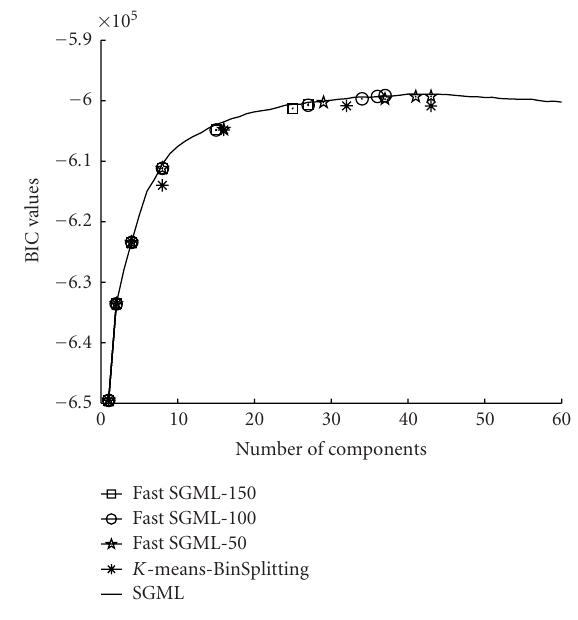
Figure 5: The learning curves of applying SGML, fast SGML, and K -means-BinSplitting in the 60-second speech data of one partic- ular male speaker in the NIST 2001 cellular data to learn diagonal covariance GMMs. The splitting confidence of the fast SGML was 150, 100, and 50, respectively, and the K -means-BinSplitting was forced to stop at GMM 43